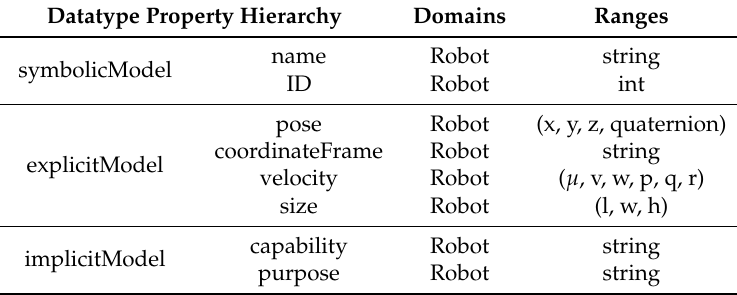
Table 5. Datatype properties for Robot